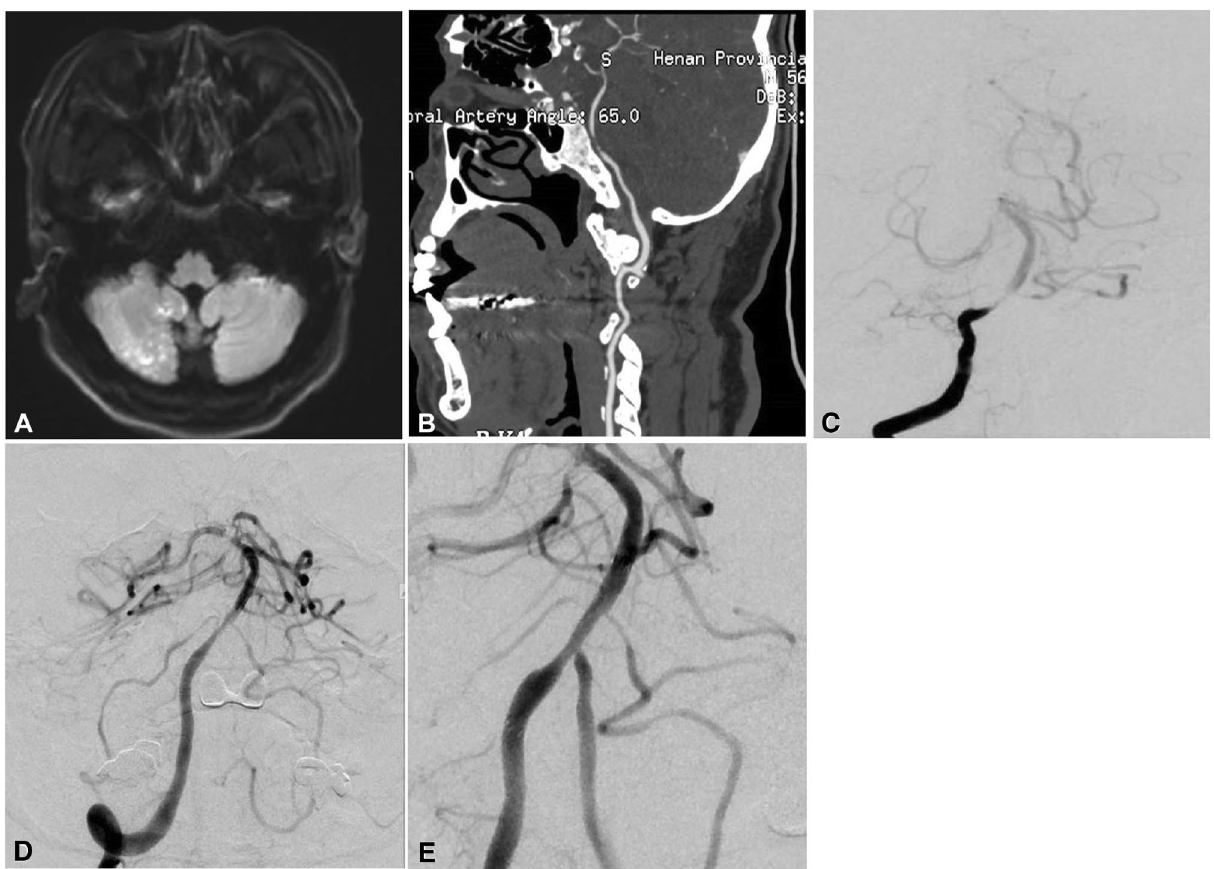
Figure 1. Severe stenosis at the lower segment of the basilar artery. ( A ) Magnetic resonance imaging (DWI) showed disperse lesions of new infarction in the right hemisphere of the cerebellum. ( B ) Computed tomography demonstrated severe stenosis at the lower segment of the basilar artery without calcification. ( C ) Digital subtraction angiography revealed severe stenosis at the lower segment of the basilar artery. ( D ) An Enterprise stent was deployed at the stenosis leading to patent flow. ( E ) Follow-up angiography at 6 months after stenting demonstrated good patency of the basilar artery at the